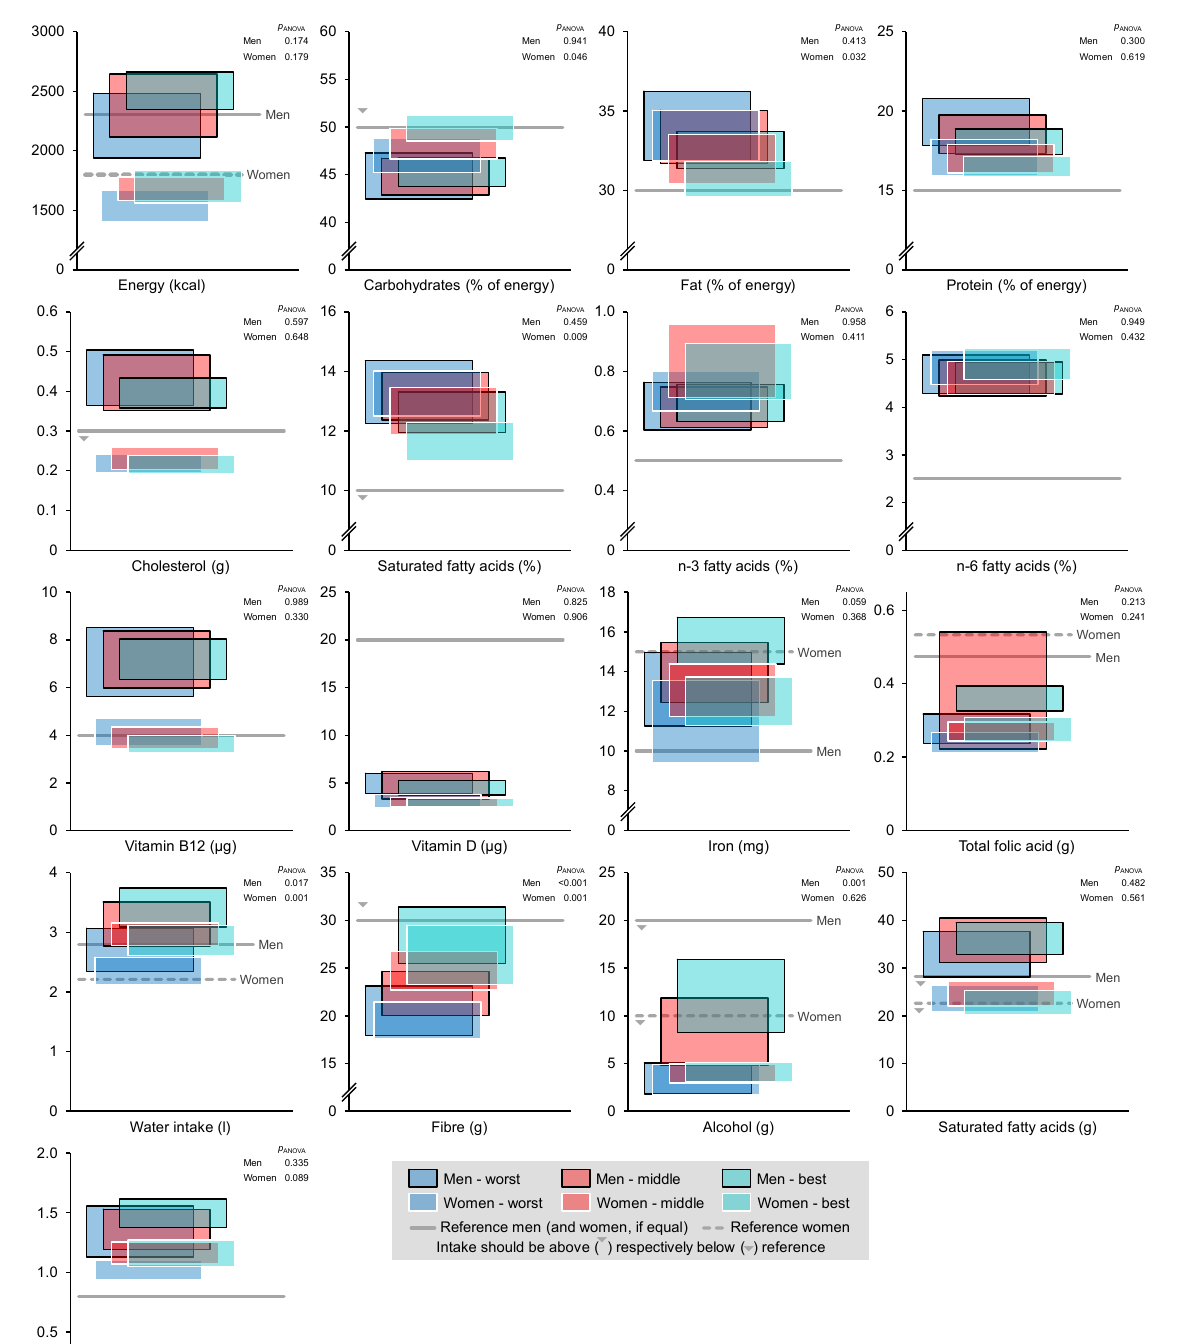
Figure 1. Dietary intake of men ( n = 167) and women ( n = 213), divided by performance groups. Displayed are 95% confidence intervals. p ANOVA : p -value of ANOVA between groups divided by sex.